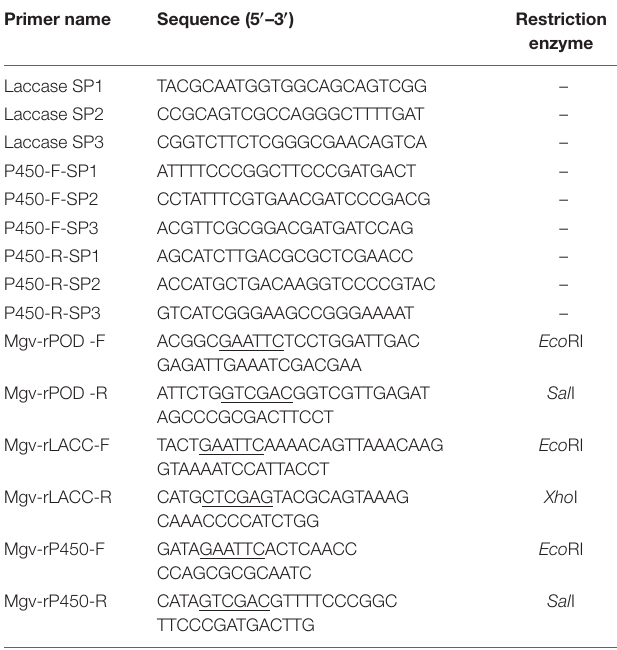
The bases underlined were restriction enzyme cutting